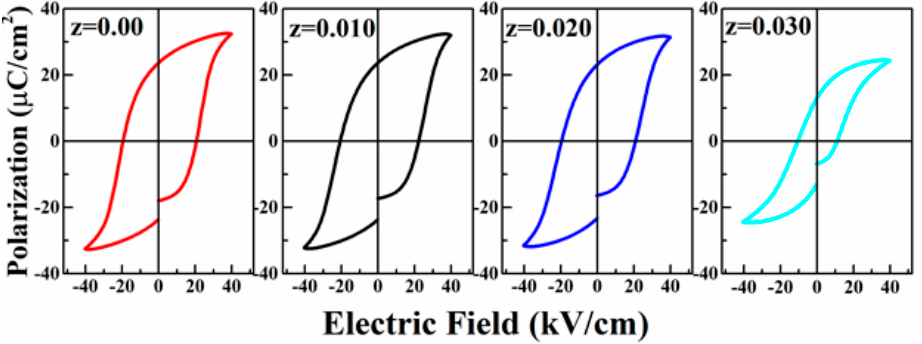
Figure 6. Ferroelectric properties of BFBT–zBCZT (z = 0.00–0.030) samples at optimized conditions. All poled samples were aged for 24 h before the measurement of the piezoelectric